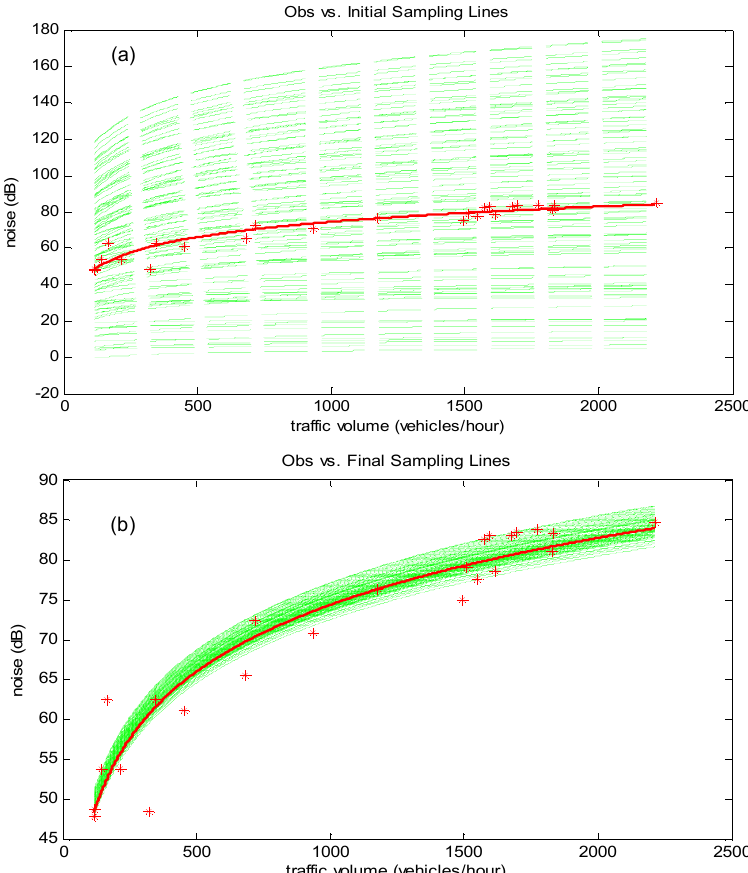
Figure 4. Initial ( a ) and updated ( b ) traffic noise prediction curves in scenario A 1.